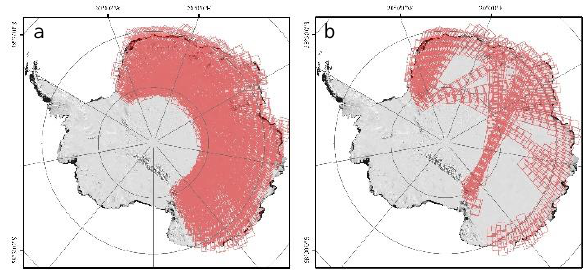
Figure 3. Coverage of Landsat images in the 70s (a) and 80s